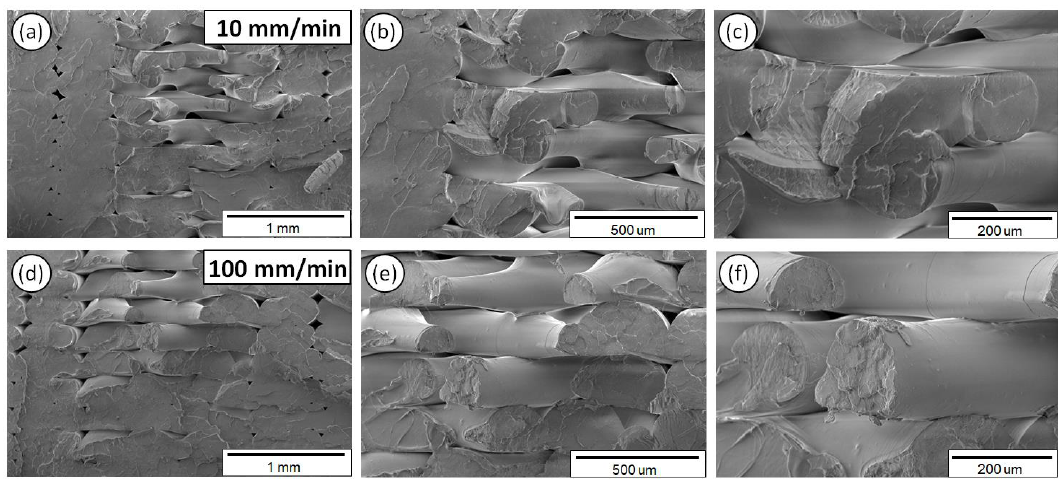
Figure 7. Side focus on 3D printed specimens of all five polymers tested; namely ( a ) PLA, ( b ) ABS, ( c ) PETG, ( d ) PA6, and ( e ) PP.